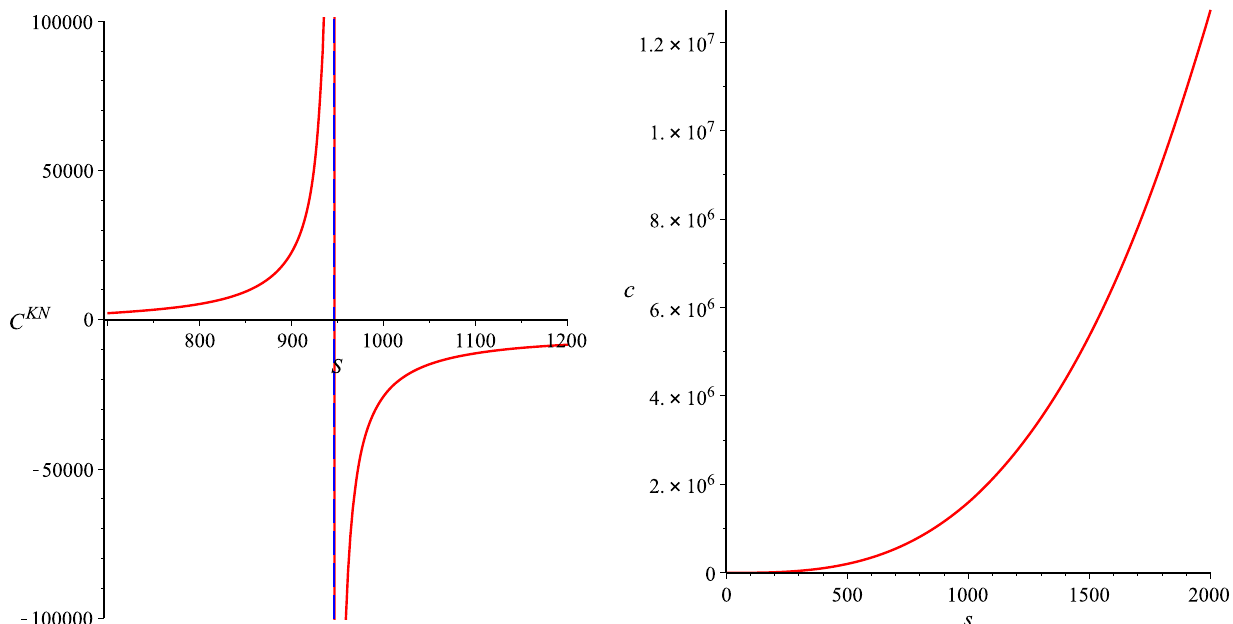
Fig. 3 Heat capacity C (left) and heat capacity c (right) as functions of the entropy S and entropy s , respectively, with J = j = 5 and Q = q =